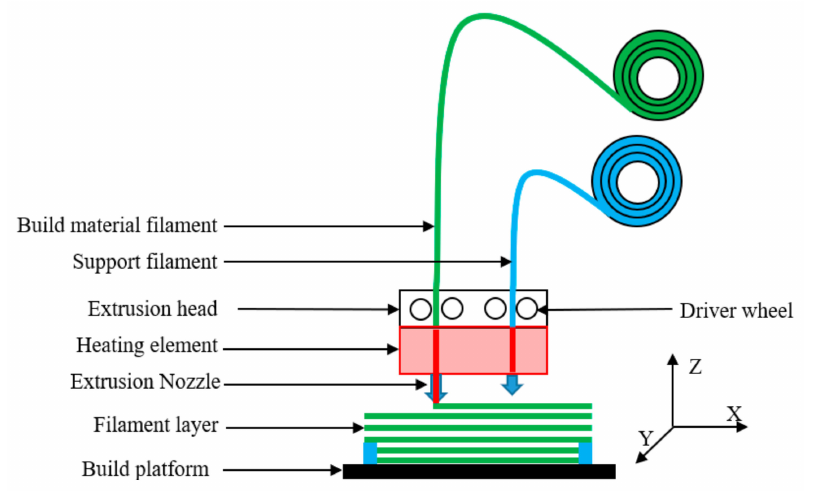
Figure 1. Working principle of fused deposition modeling.